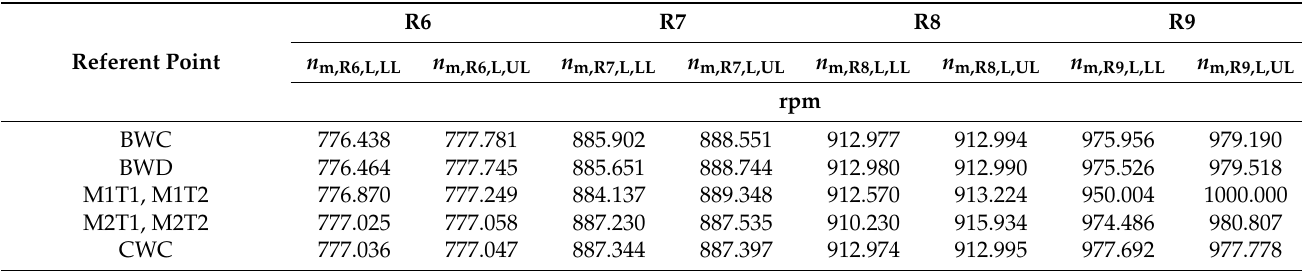
Table 10. Boundaries of the FREM resonant domains according to a L,per –EHO: 3.